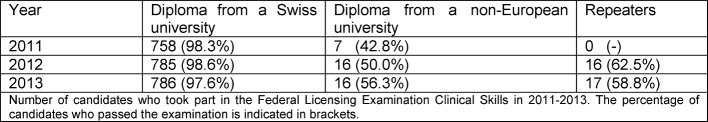
Number of candidates and pass rate for the Federal Licensing Examination Clinical Skills 2011-2013